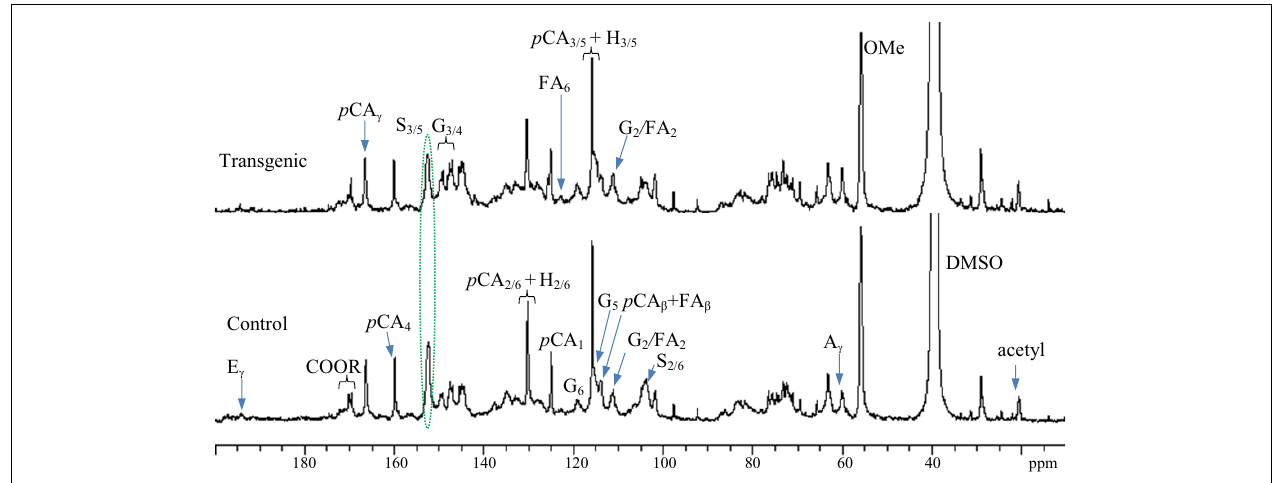
FIGURE 2 | Quantitative 13 C NMR spectra of enzyme lignins isolated from switchgrass internode I1 samples (Bottom: control; top: transgenic) . A, β -O-4; G, guaiacyl; S, syringyl; H, p -hydroxyphenyl; p CA, p -coumarate; FA, ferulate; E, cinnamyl aldehyde; OMe, methoxyl.